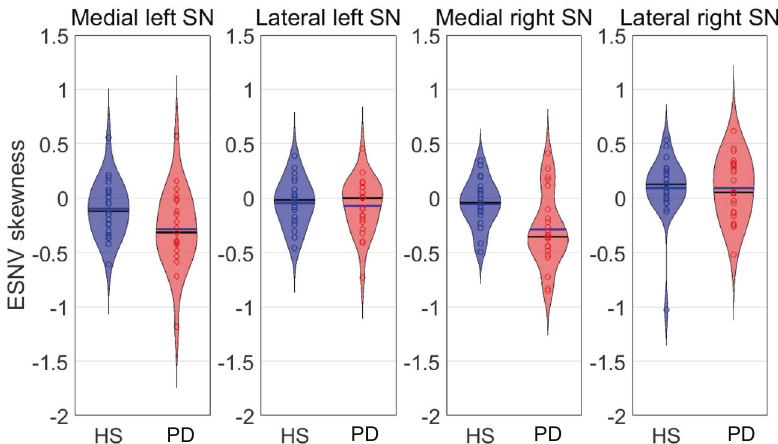
Fig. 2 Effective substantia nigra values (ESNV) skewness violin plot. ESNV skewness distribution in HC and PD patients in the four SN subregions (PD patients are depicted in red and HC in blue).